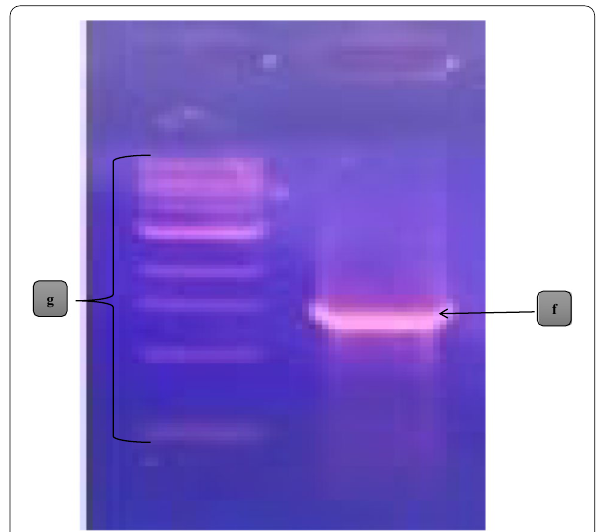
Fig. 5 PCR product of 16S rRNA region of Bacillus safensis bacteria on agarose gel, a isolates no. 12, b isolates no. 18, c isolates no. 6, d isolates no. 66, e isolates no. 70, f: Bacillus safensis (1500 bp), g Ladder (10,000 bp)